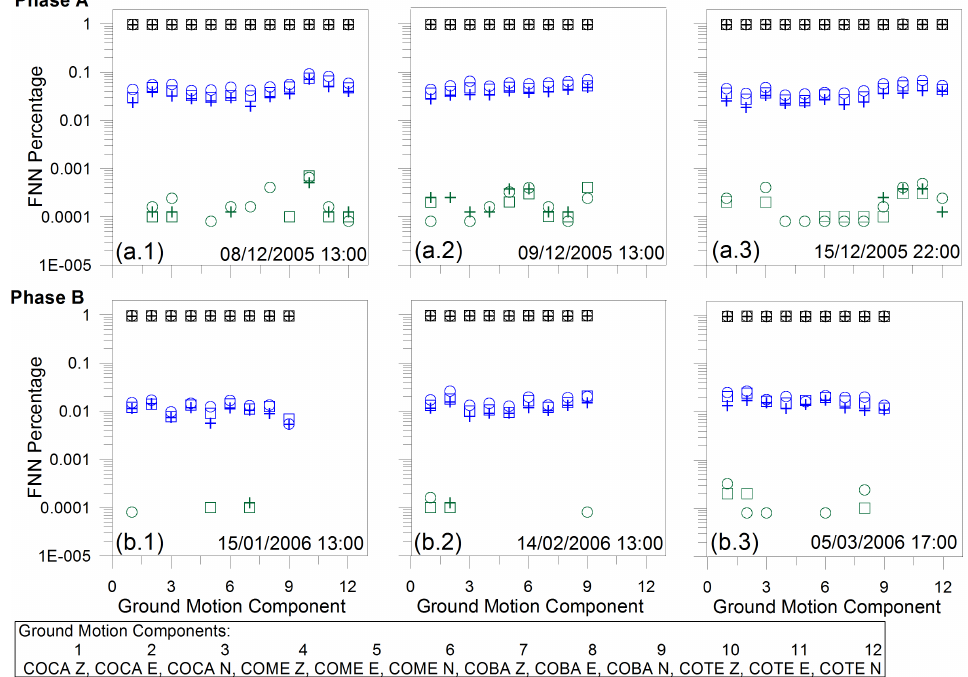
Fig. 5. Fractions of FNN vs. ground motion components. The symbols in each panel represent the fraction of FNN for the corresponding station and ground motion component relative to the embedding dimension equal to 1 (black), 2 (blue), 3 (green). Different symbols are used for different sample lengths: circles for 256s, squares for 320s and crosses for 400s. The upper panels (a.1, a.2 and a.3) are associated to Phase A and the bottom (b.1, b.2 and b.3) to Phase B. The legend at the bottom shows the correspondence between the numbers indicated in the horizontal axes and the ground motion components.